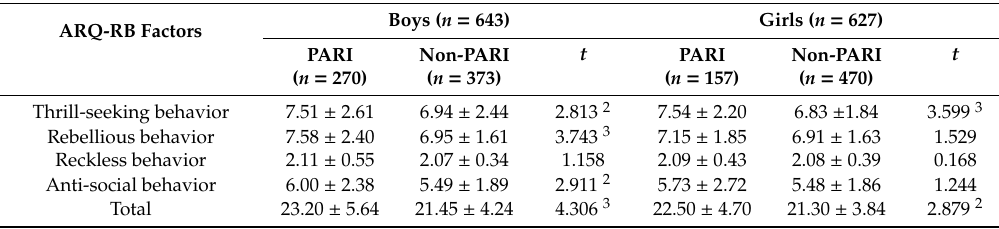
Table 3. Comparison of Adolescent Risk-taking Questionnaire–Risk Behavior Scale (ARQ-RB) scores